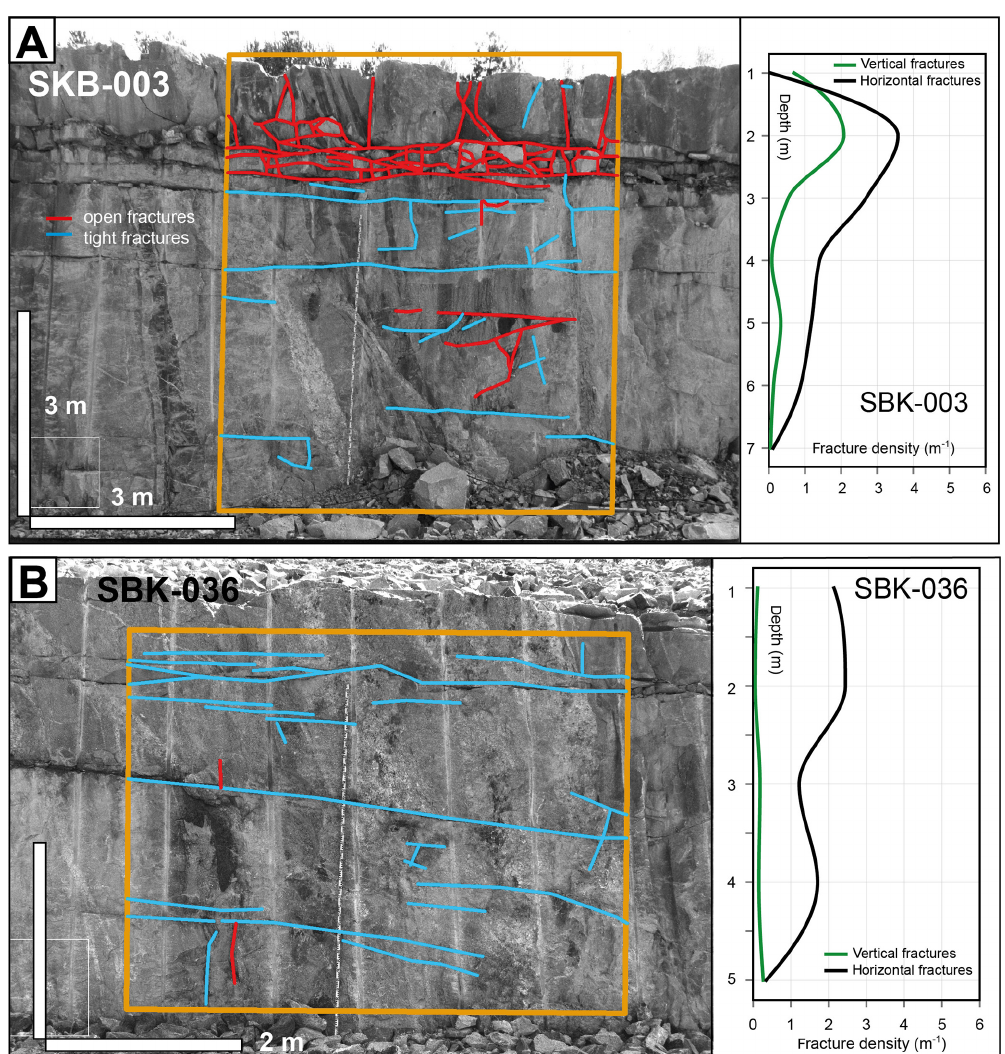
Figure 6. 2-D fracture analysis applied to historic photographs of excavations during the construction of the Forsmark nuclear power plant, eastern Sweden. Open and tight fractures (red and blue) were digitized. Fracture density was calculated separately for sub-vertical and horizontal fractures. Photos: Göran Hansson, see Carlsson (1979); photos available in the archive of the Swedish Nuclear Fuel and Waste Management Company